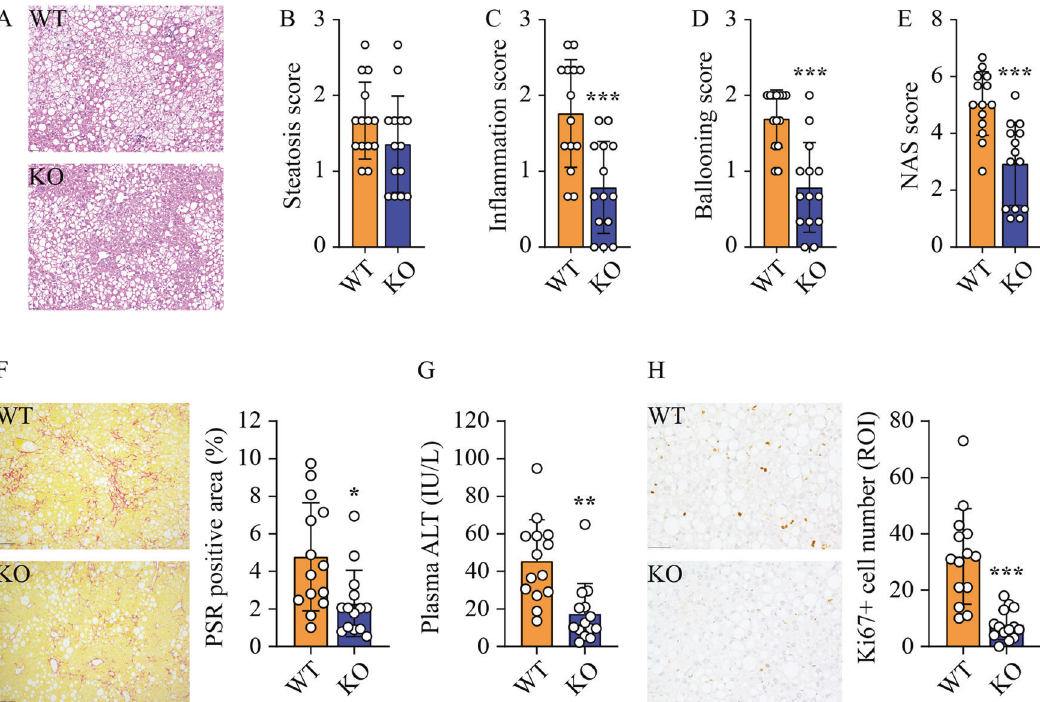
Fig. 2 Sphk2 -KO mitigates HCC-promoting pathological changes in non-tumorous liver tissues. Wild-type (WT) and Sphk2 knockout (KO) mice were fed with a high-fat, high-sugar diet (HFHSD) for 46 weeks. A H&E staining of non-tumorous liver tissues. B Steatosis, C in fl ammation and D ballooning were scored based on the H&E staining. E NAFLD activity score (NAS) was the unweighted sum of steatosis, in fl ammation, and ballooning scores. F Hepatic fi brosis in non-tumorous tissue was visualized and quanti fi ed using Picro Sirius Red (PSR) staining. G Plasma ALT level. H Cell proliferation in non-tumorous tissue of WT and KO livers was stained and quanti fi ed by Ki67 immunohistochemistry. Scale bar = 50 µm. Data are expressed as mean ± SD. n = 14. * p < 0.05; ** p < 0.01; *** p < 0.001; versus